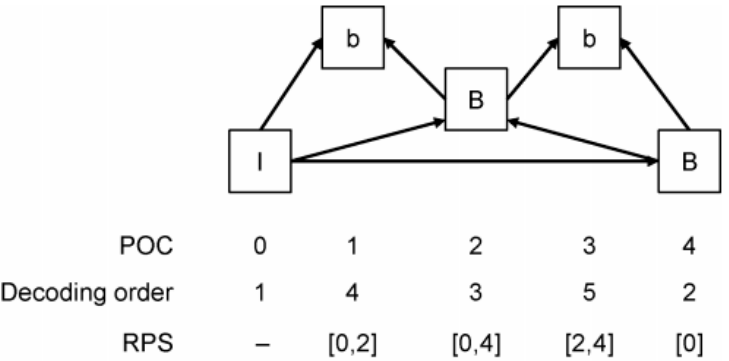
Figure 2. Example of a temporal prediction structure in HEVC inter coding.